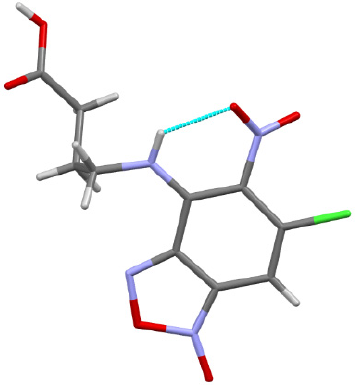
Figure 8. Intramolecular H-bond in 4l .